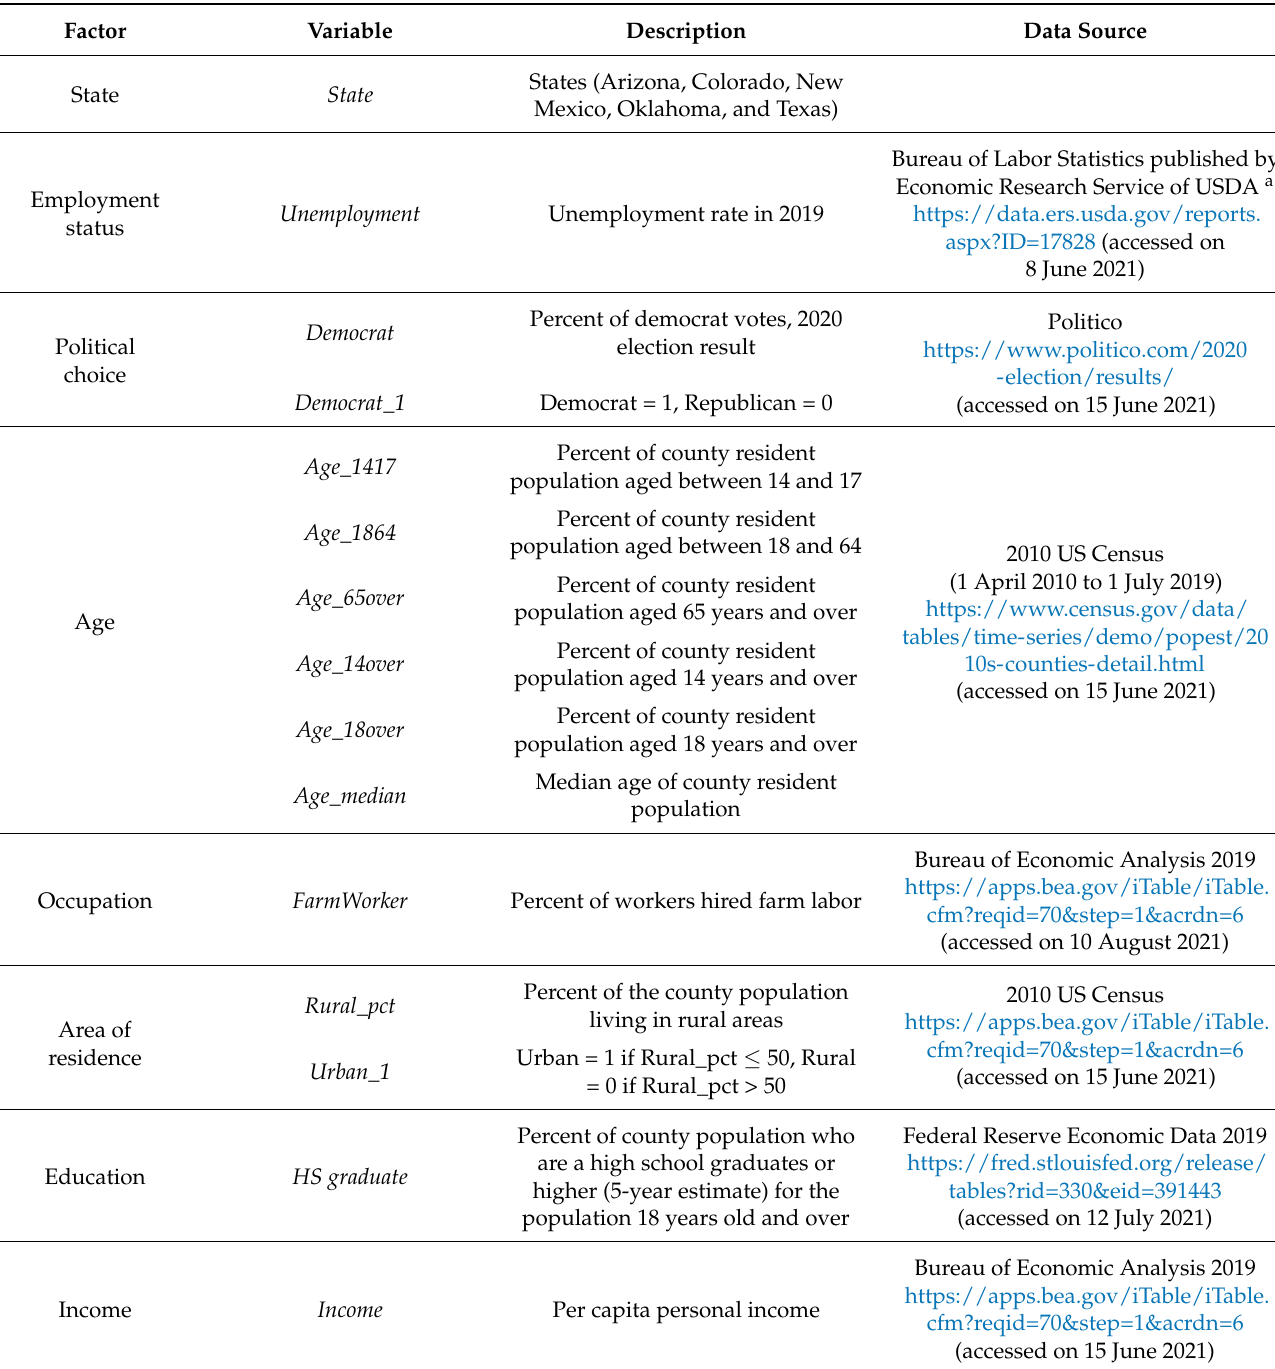
Table 1. Variables and data sources used in the study of COVID-19 vaccination